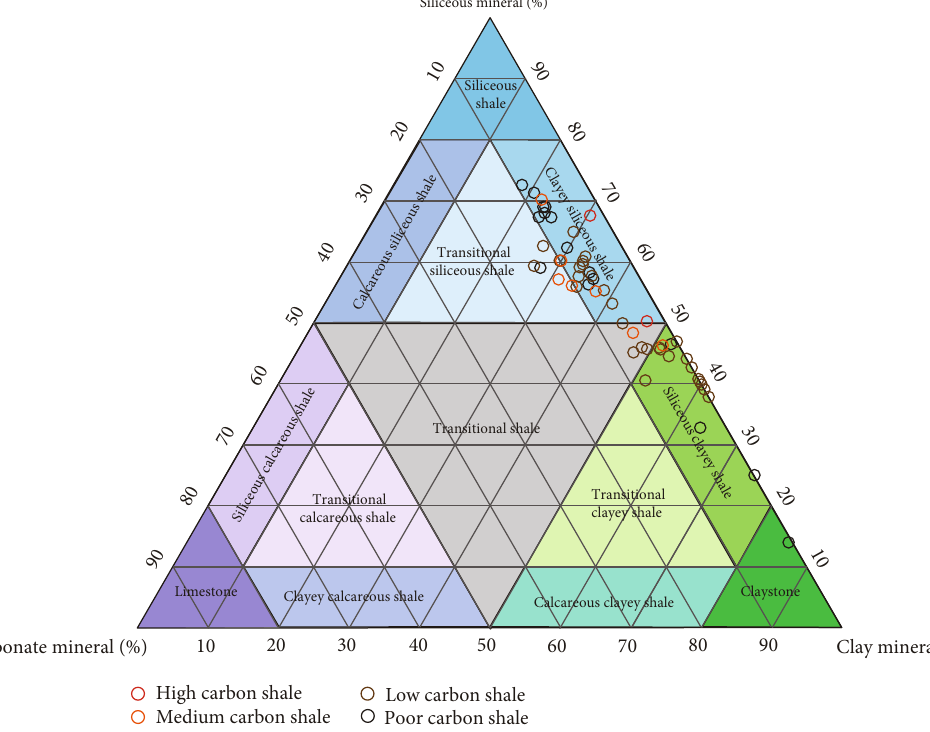
Figure 3: Classi fi cation of shale facies and comparison of organic carbon